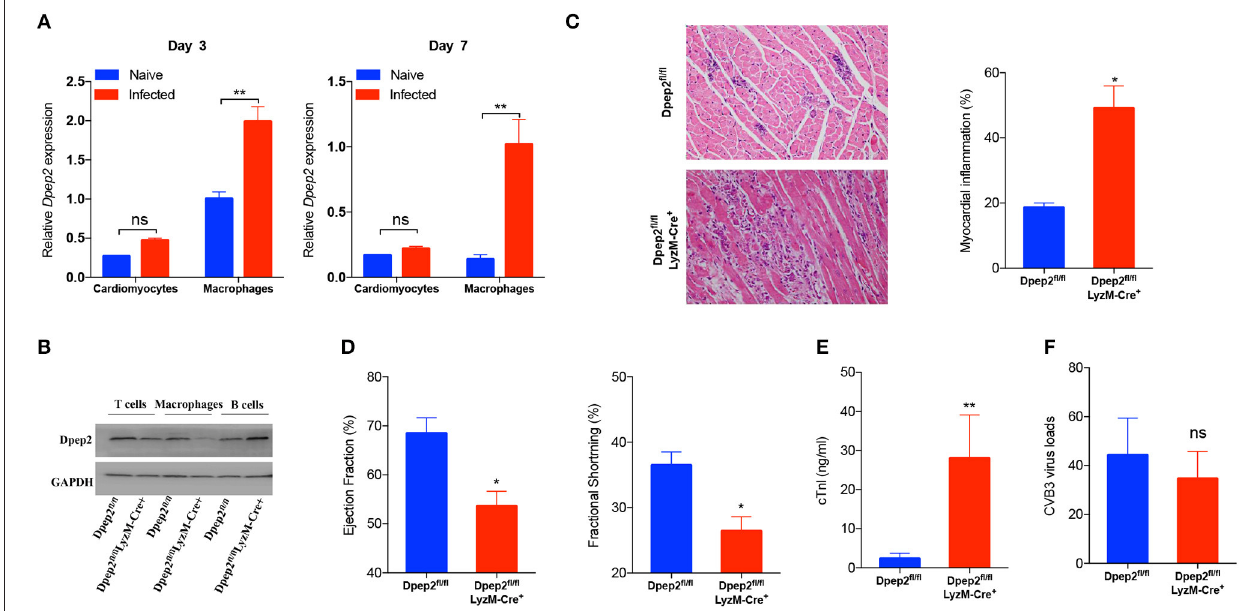
FIGURE 2 | Macrophage Dpep2 deficiency could remarkably aggravate viral myocarditis. (A) Dpep2 expression in the cardiomyocytes and tissue-infiltrating macrophages was examined by real-time PCR on day 3 and 7 post CVB3 infection. (B) The Dpep2 expression in T cells, B cells, and BMDMs from Dpep2 fl / fl and Dpep2 fl / fl LyzM-Cre + mice were measured by Western blot. (C) Myocarditis severity was evaluated by pathological observation (magnification: 200 × ) and percentage of myocardial inflammation. (D) Ventricular systolic function was measured using Left ventricular ejection fraction (LVEF) and Left ventricular fractional shortening (LVFS) on day 7. (E) The serum cTnI levels were detected by ELISA. (F) Viral loads in the myocardium was detected by real-time PCR. Individual experiments were conducted three times with similar results and the representative data were shown. Data were presented as the means ± S.E.M. * p < 0.05; ** p < 0.01; ns, no